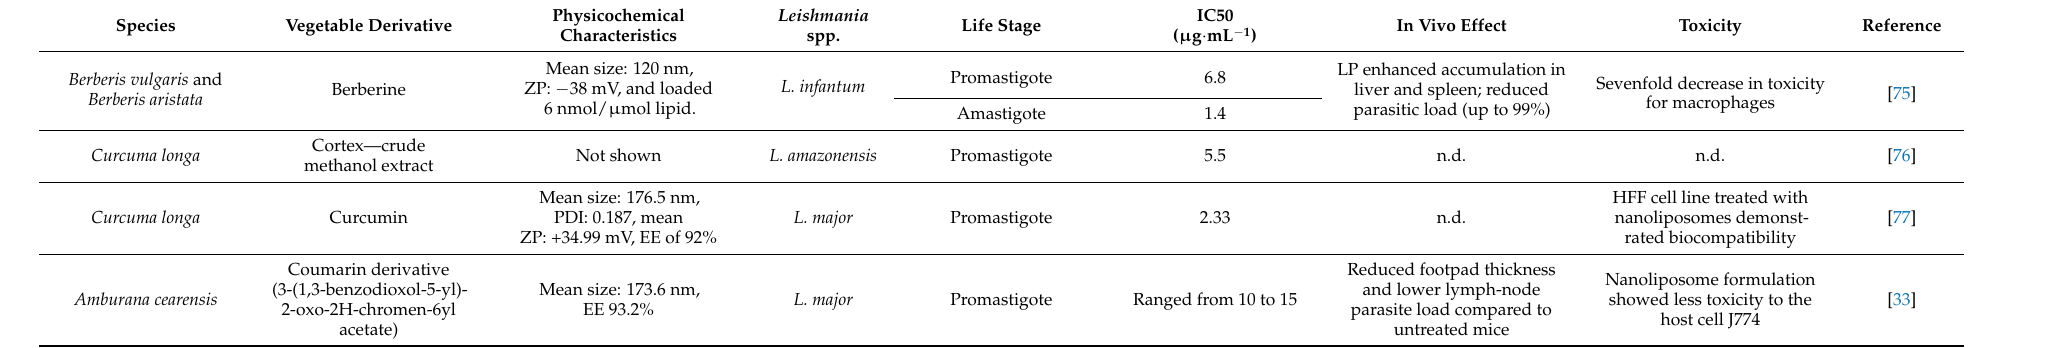
Table 2. Plant-based liposomal formulations as leishmanicidal